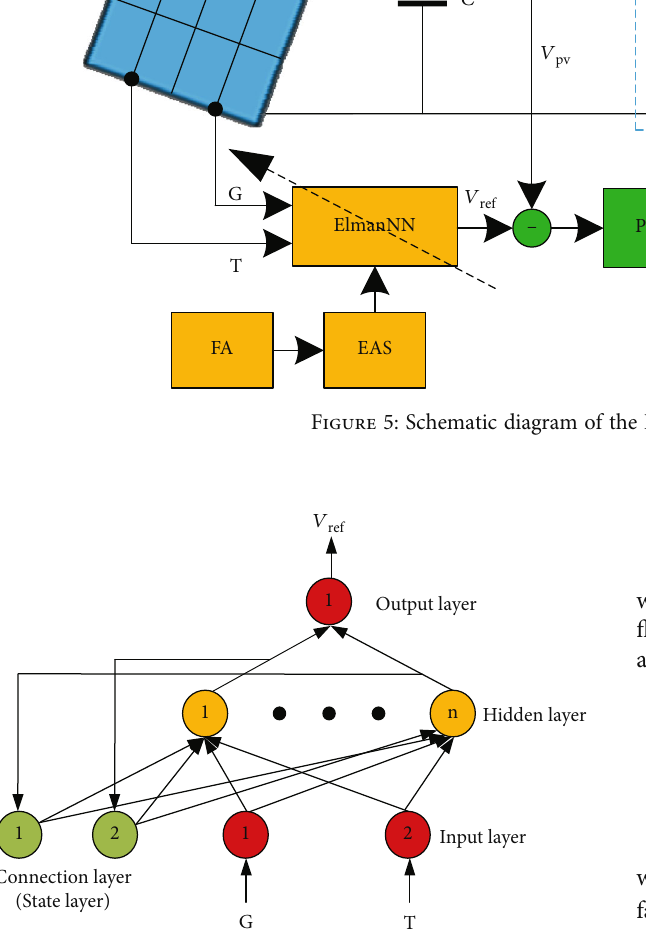
Figure 6: The structure of ElmanNN.